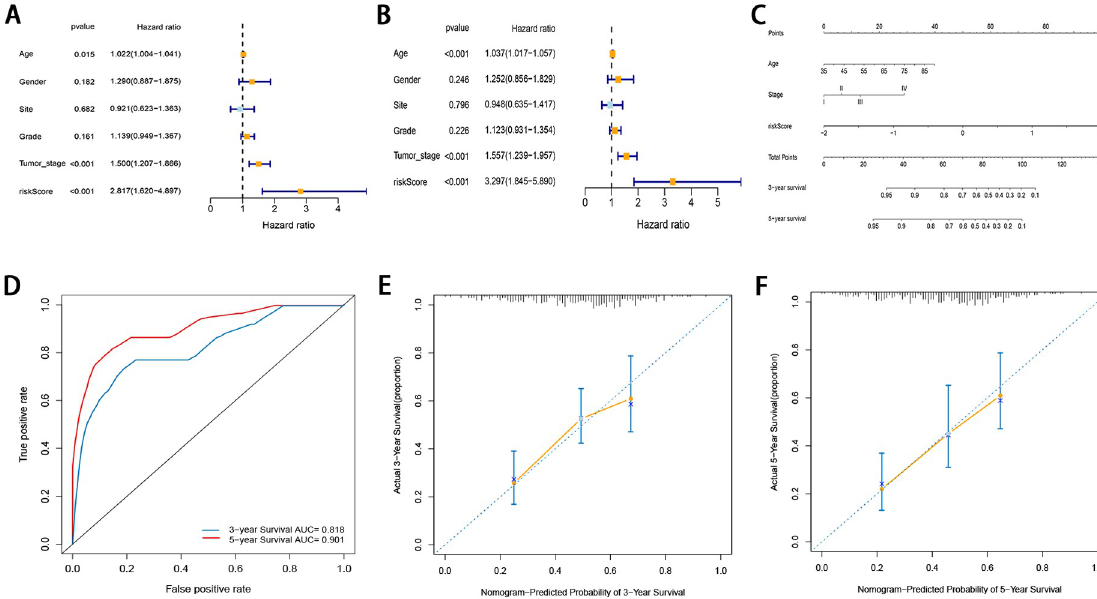
Fig 7. (A, B) Univariate and multivariate Cox regression analyses regarding OS in GC patients (C) Nomogram based on risk score, age, and tumor stage (D) Time-dependent ROCs for 3-year and 5-yearOS of the nomogram (E, F) Calibration curves of the nomogram prediction of 3-year and 5-year OS of patients with